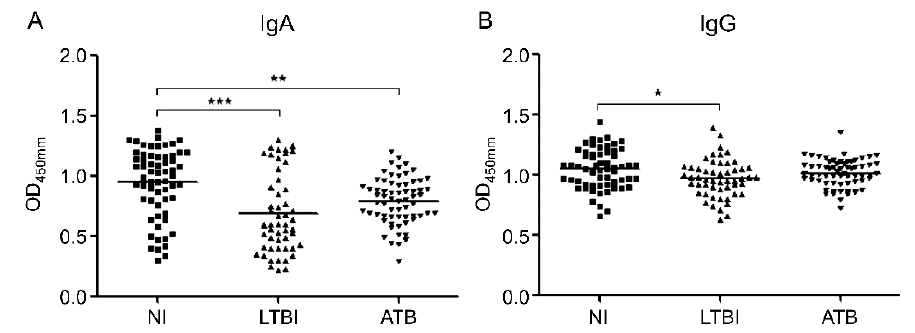
Figure 1. Optical density (OD) values of the anti-macrophage migration inhibitory factor (MIF) immunoglobulin (Ig)A ( A ) and anti-MIF IgG ( B ) serodiagnostic assays for the comparison of 65 active tuberculosis (ATB) patients, 53 latent tuberculosis infection (LTBI) patients, and 62 non-infected (NI) individuals. Each dot represents the values obtained from individuals; horizontal bars indicate the mean values. The groups were compared using one-way ANOVA with Bonferroni’s multiple comparisons. * p < 0.05; ** p < 0.01; *** p < 0.001.